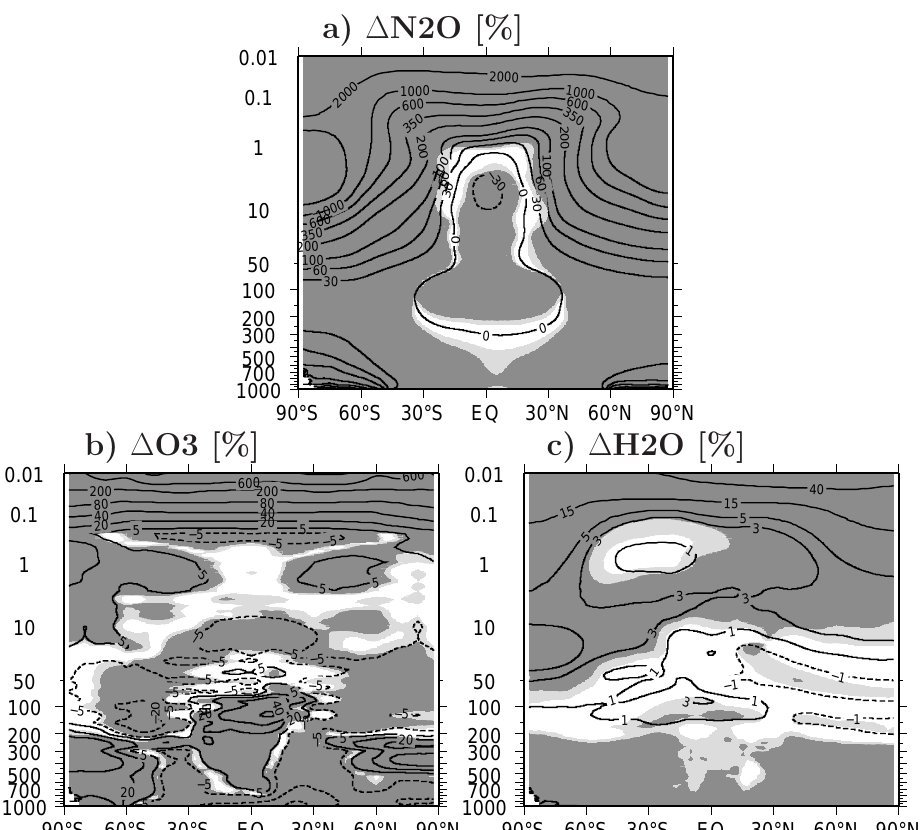
Fig. 7. Same as Fig. 6, but only for the per-cental deviation of simulation decoup full versus coup full (see Table 1) and offline fields in case of decoup full (a and b only). (a) 1 N 2 O [%], (b) 1 O 3 [%], and (c) 1 H 2 O [%] (gaseous only). Note that in case of decoup full there are two different sets, offline and online, of the radiatively active species N 2 O, O 3 , CFC-11, CFC-12, and CH 4 : the radiation submodel RAD4ALL uses the offline climatologies, whereas chemistry and transport impact the online